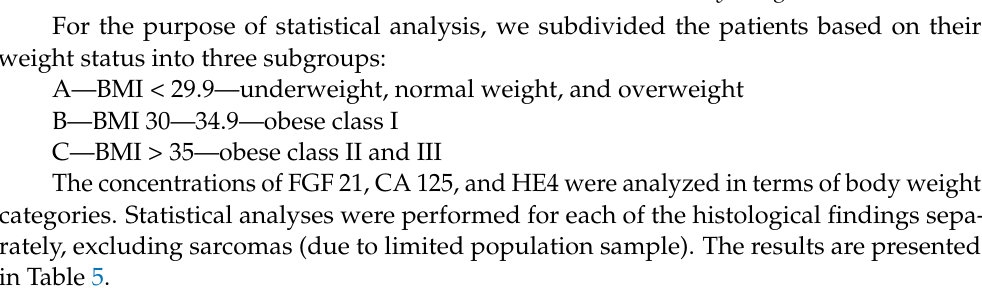
Table 5. Comparison of variable distributions between different tumor histologies, accounting for patients’ body